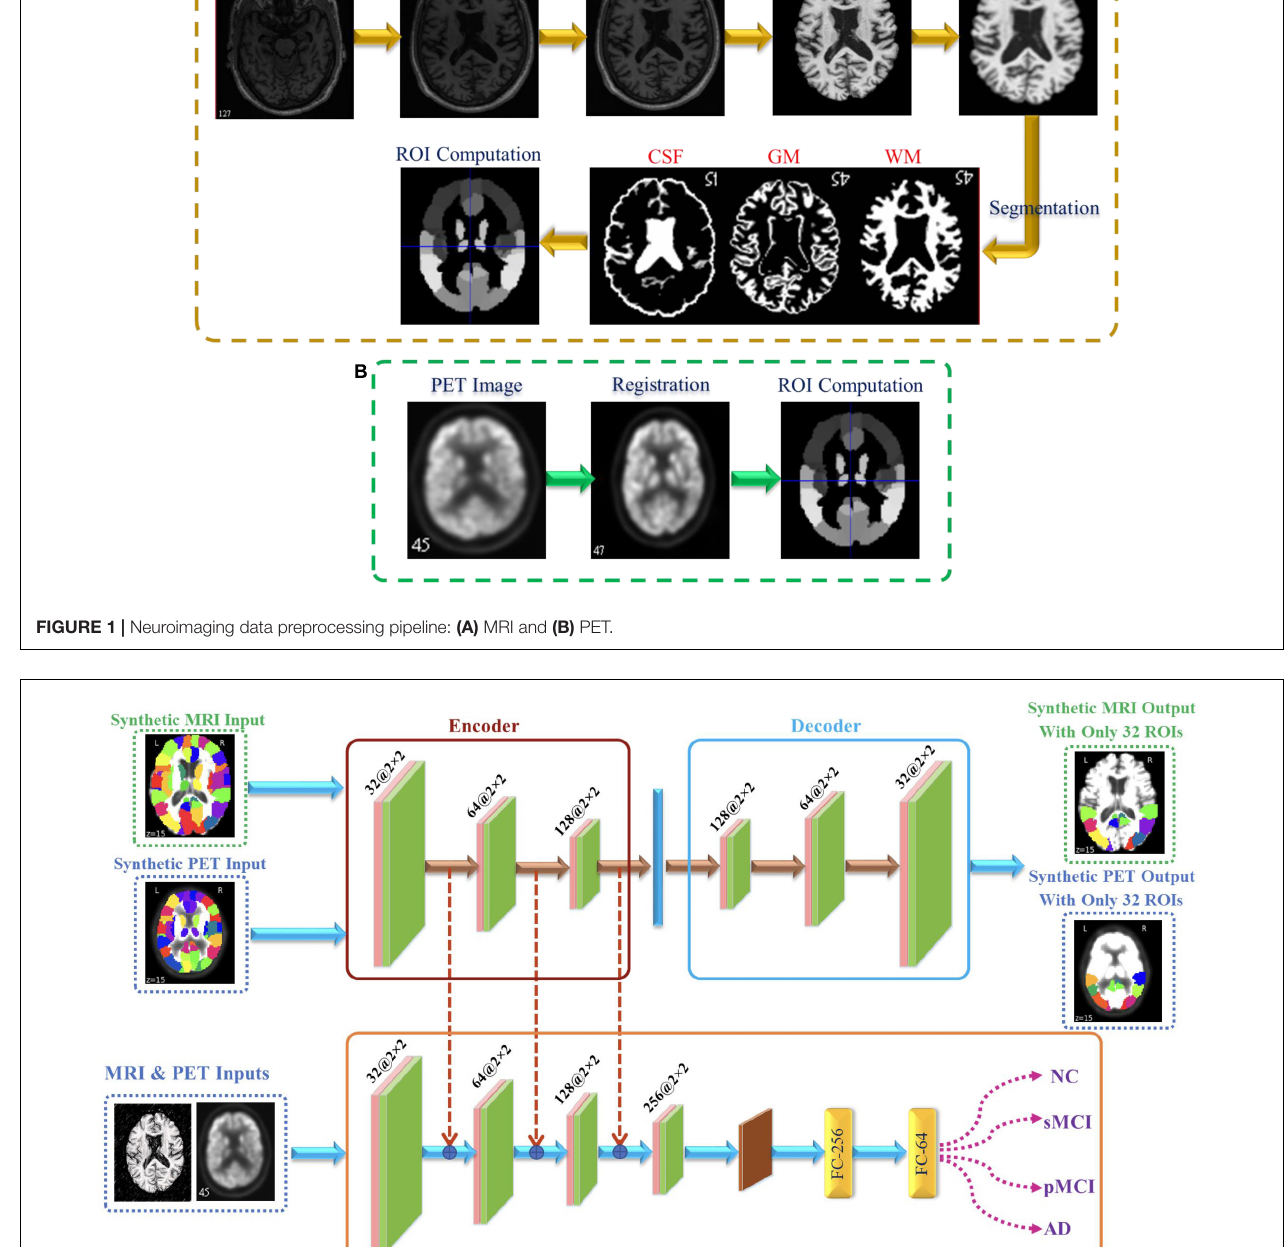
In the proposed architecture, we use three convolutional layers for each synthetic image such that the rectified linear unit (ReLU) activation function and batch normalization are